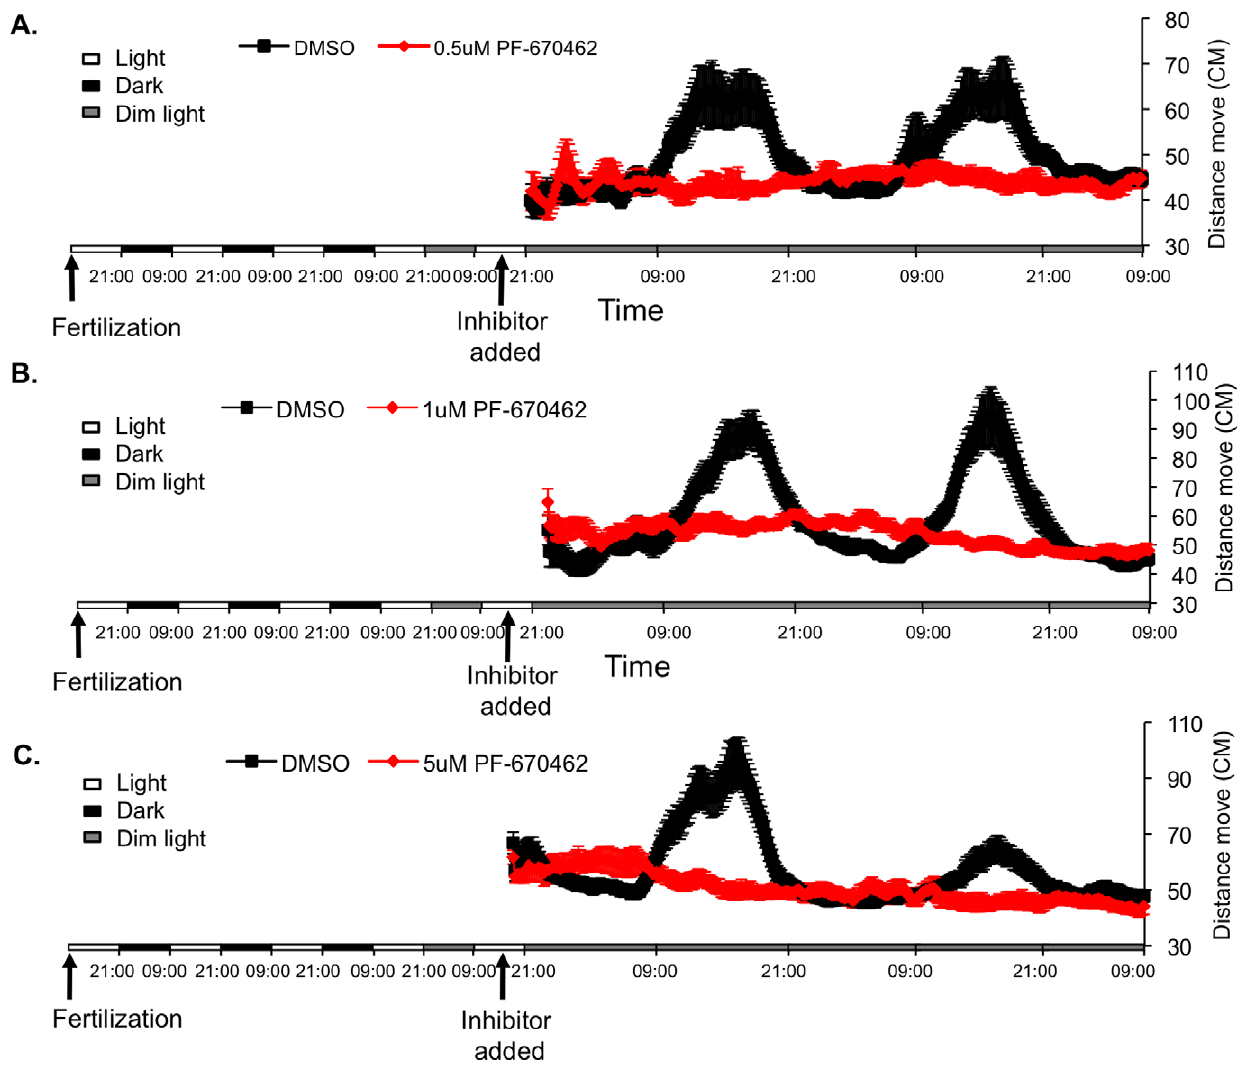
Figure 3. CK1 d inhibition disrupts clock-controlled rhythmic locomotor activity in zebrafish larvae. Locomotor activity of zebrafish larvae was detected by the DanioVision observation chamber. The PF-670462 inhibitor was added to the water at 5 dpf at different concentrations, A- 0.5 m M, B-1 m M and C-5 m M (red lines). Control larvae were treated with DMSO at the same concentrations (black lines). The larvae were kept under constant conditions (dim light) and the distance moved (cm, y-axis) was recorded over time (hours, x-axis). The horizontal bars represent the light conditions before and during the experiment. White boxes represent light, black boxes represent dark and grey boxes represent dim light. The rhythm of locomotor activity was completely abolished by the CK1 d